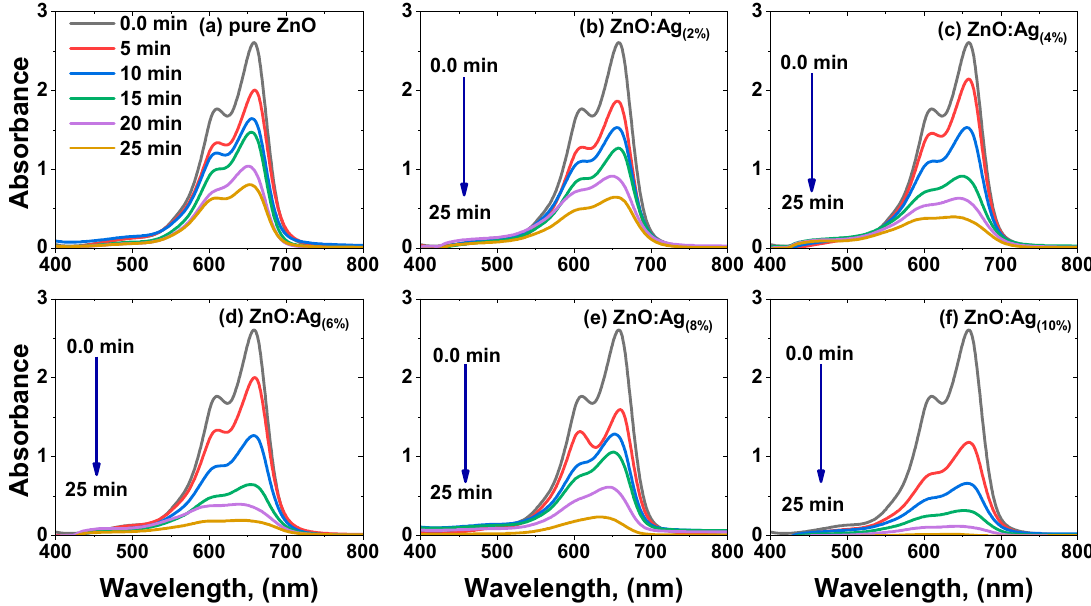
Figure 9. UV–Visible absorption spectra of MB dye using ( a ) pure ZnO, ( b ) ZnO:Ag (2%) , ( c ) ZnO:Ag (4%) , ( d ) ZnO:Ag (6%) , ( e ) ZnO:Ag (8%) , and ( f ) ZnO:Ag (10%) .